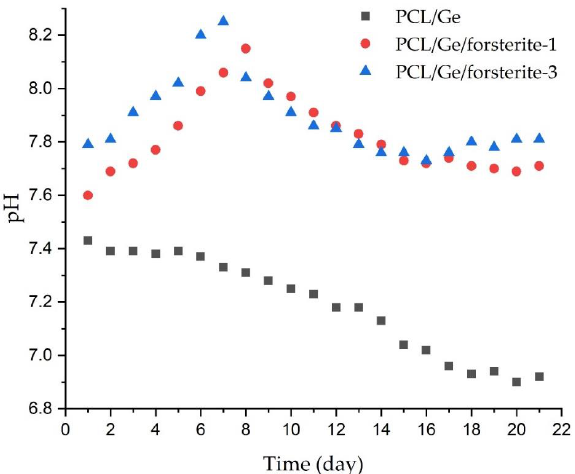
Figure 4. The pH values of the PBS solutions containing PCL / Ge with 0, 1 and 3 wt.% forsterite during 21 days immersion.